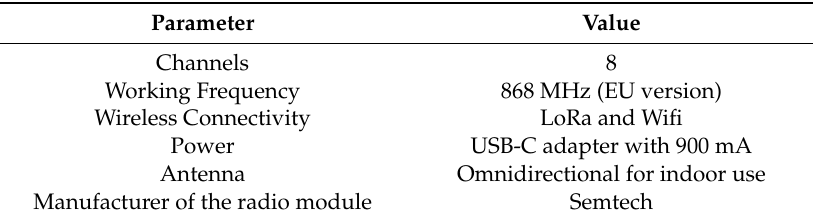
Table 2. Features of TTN gateway.